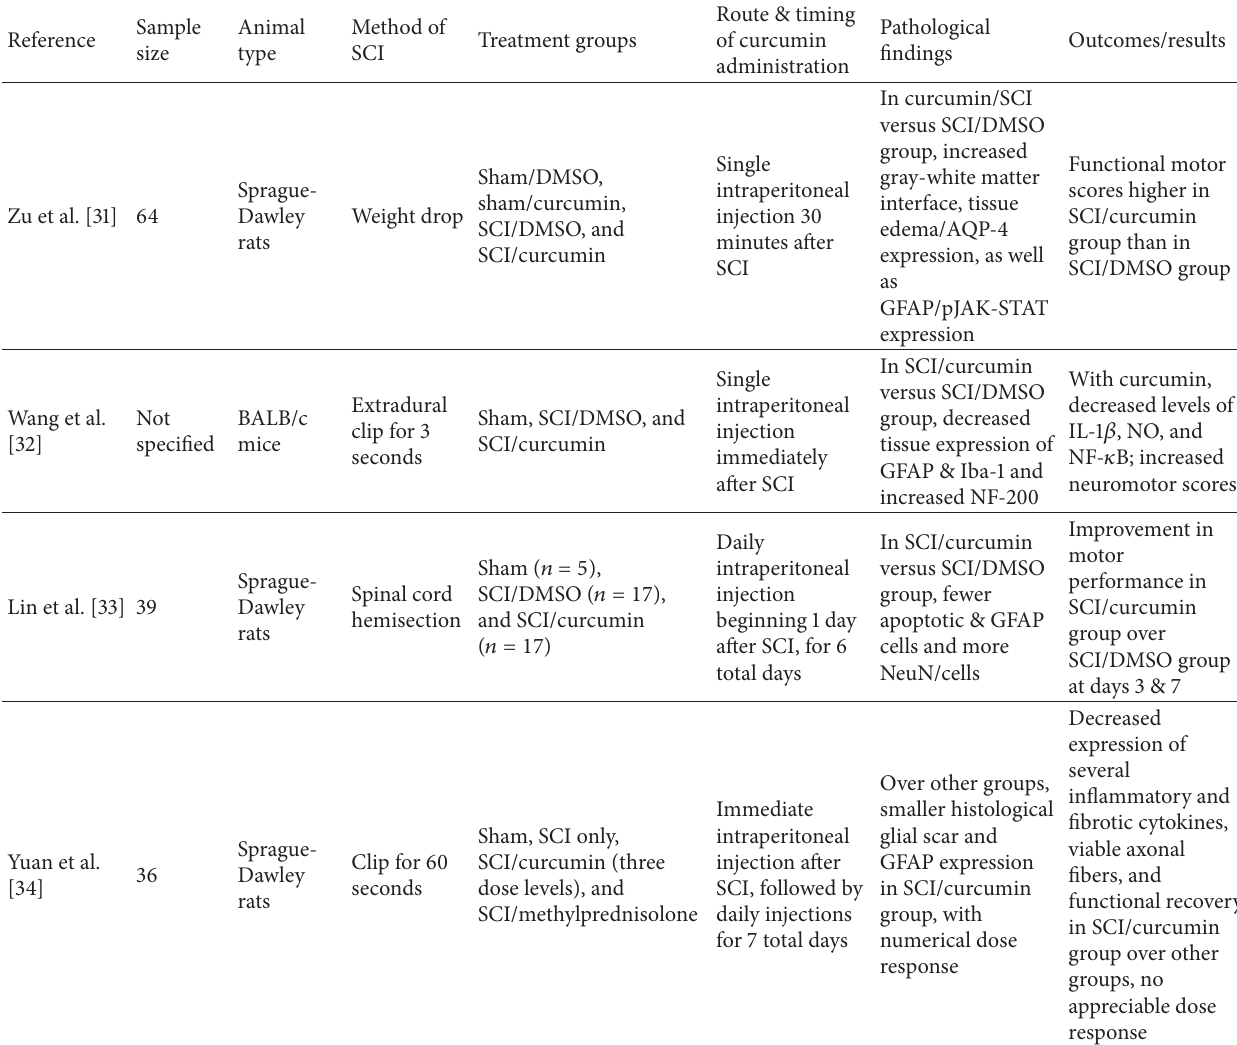
Table 3: Publications examining the anti-inflammatory and fibrotic properties of curcumin. Groups equally divided unless otherwise indicated. SCI, spinal cord injury; DMSO, dimethyl sulfoxide; AQP-4, aquaporin-4; GFAP, glial fibrillary acidic protein (astrocyte marker); pJAK-STAT, phosphorylated Janus kinase-signal transducers and activators of transcription; Iba-1 (microglial marker); NF-200, neurofilament-200 (neuron marker); IL-1 𝛽 , interleukin-1 𝛽 N (inflammatory mediator); NO, nitric oxide (inflammatory mediator); NF- 𝜅